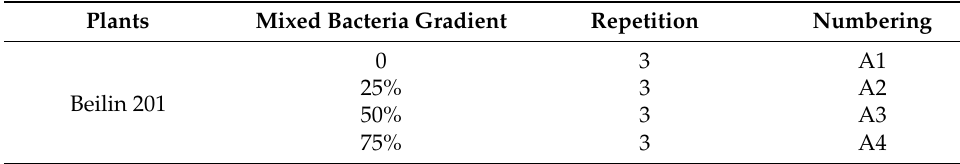
Table 1. Description of seed dressing dose.